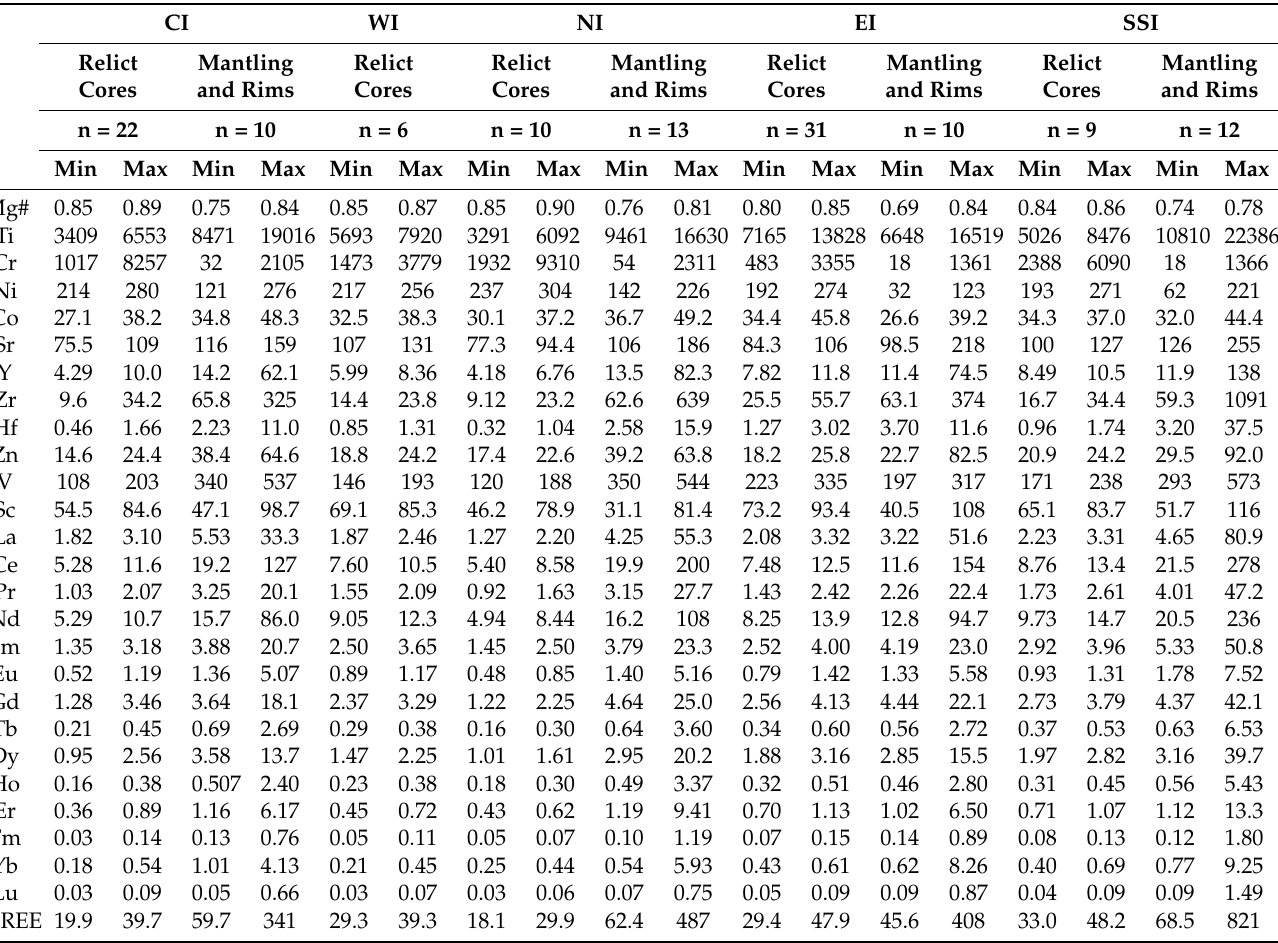
Table 2. Summary of compositional ranges for trace element analysis on clinopyroxenes from the Ponte Nova massif. Mg# = [Mg/(Mg + Fe T ), cationic proportions]. Individual analysis can be accessed in the Supplementary